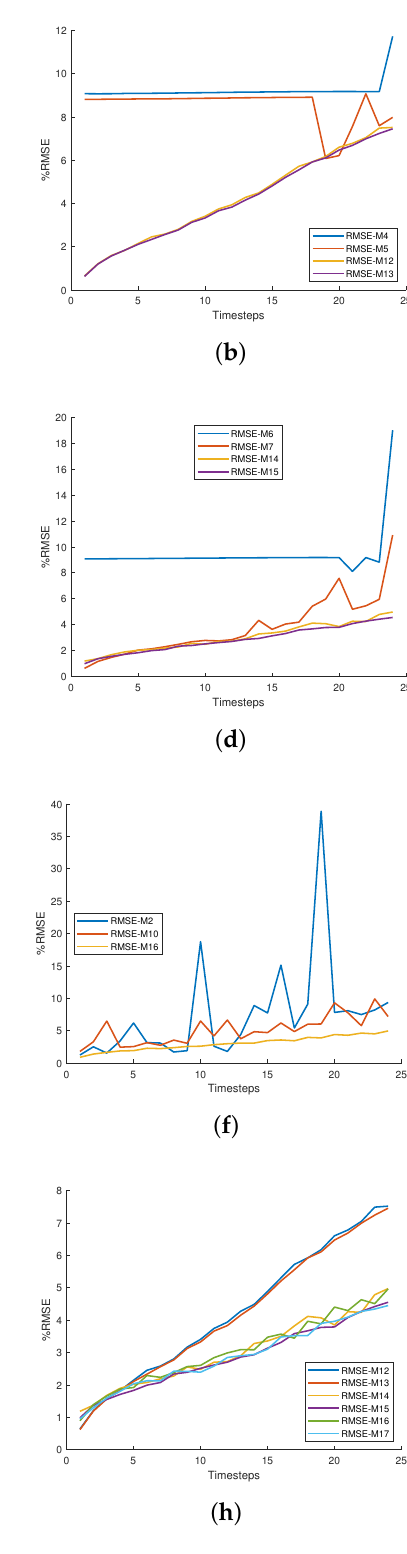
Figure 6. Comparison of spatial, temporal, spatial–temporal, and mixed approaches: ( a ) spatial input; ( b ) spatial output ; ( c ) temporal input; ( d ) temporal output ; ( e ) spatial–temporal input; ( f ) spatial–temporal output ; ( g ) mixed approaches; ( h ) mixed